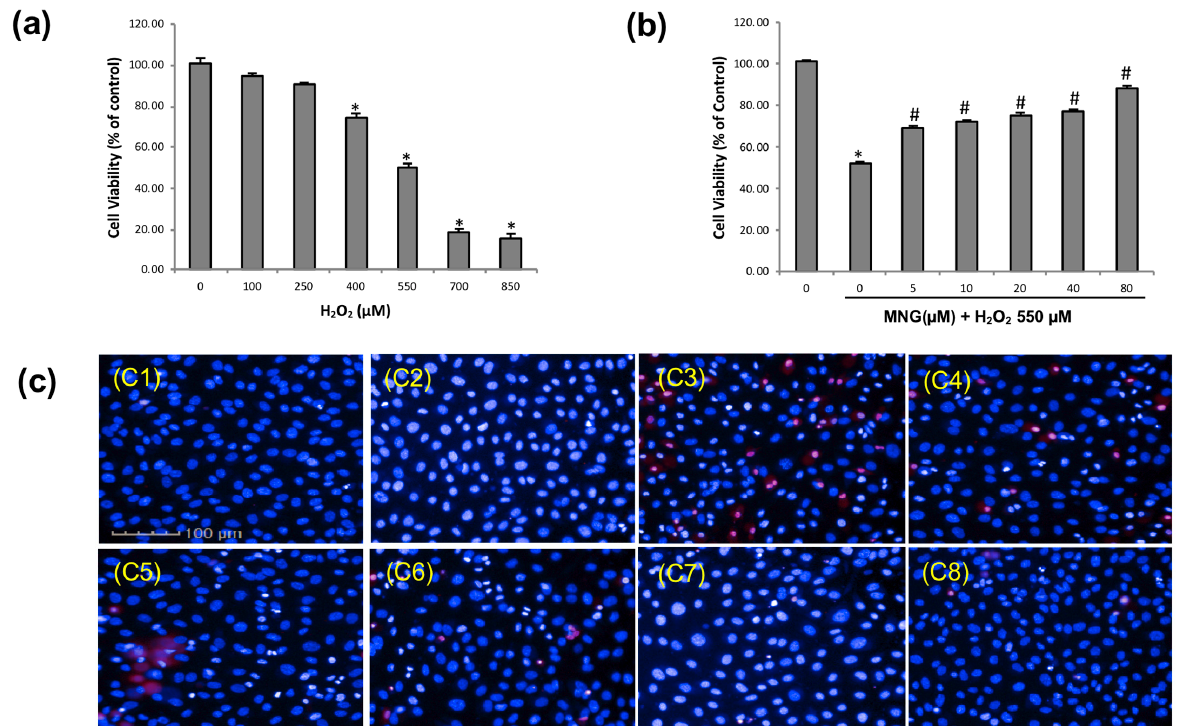
Figure 5. Protection of EA.hy 926 cells by MNG against H 2 O 2 -induced cell death. ( a ) Cells were treated with 550 μ M H 2 O 2 for 6 h. H 2 O 2 caused a concentration-dependent reduction of cell viability in EA.hy926 cells. ( b ) Cells were pretreated with 0–80 μ M MNG for 24 h, followed by incubation with or without 550 μ M H 2 O 2 for 6 h. Cytoprotection of MNG against H 2 O 2 -induced injury in EA.hy926 cells showed a dose-dependent enhancement from 5 μ M to 80 μ M. Cell viability was determined by using the MTT assay. * p < 0.05 vs. control group, # p < 0.05 vs. 550 μ M H 2 O 2 group. Data are the means ± SEM of 3 independent experiments. ( c ) Cell death was determined by using Hoechst 33,342 and PI double fluorescent staining C1: control; C2: 80 μ M MNG; C3: 550 μ M H 2 O 2; C4 − C8: 5, 10, 20, 40, 80 μ M MNG + 550 μ M H 2 O 2 ; scale bars represent 100 μ m